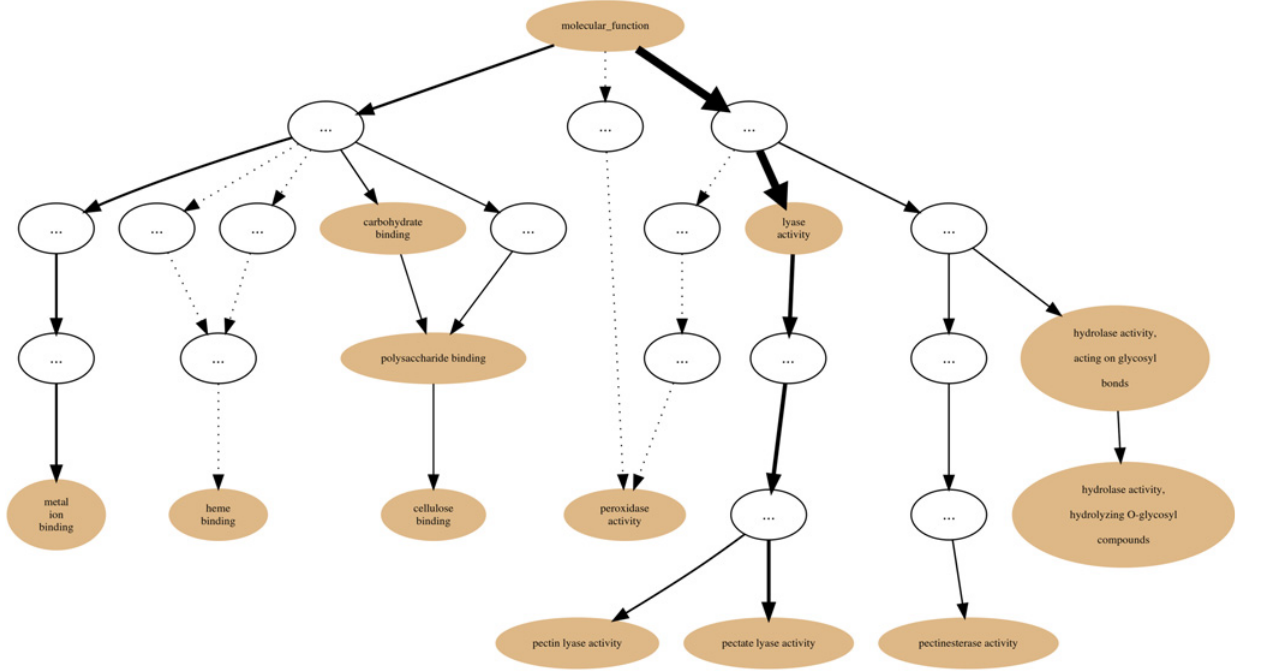
Fig 4. PL1 annotation graph. Annotation graph subsuming the PL1 (CAZy family) Set GO molecular function sub-ontology annotations.